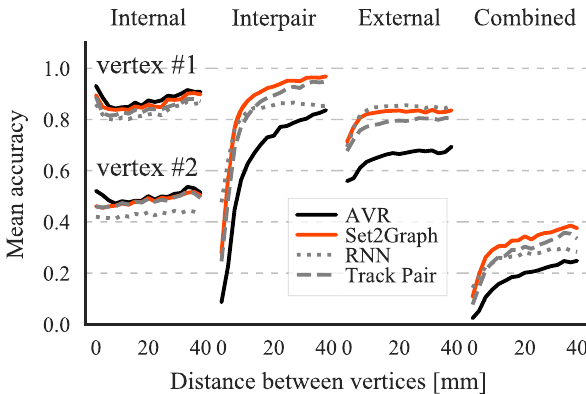
Fig. 11 Vertex pair accuracy as a function of distance between the vertices. The internal accuracy is shown for both smaller vertex (the vertex with fewer tracks, vertex #1) and the larger vertex (vertex #2)